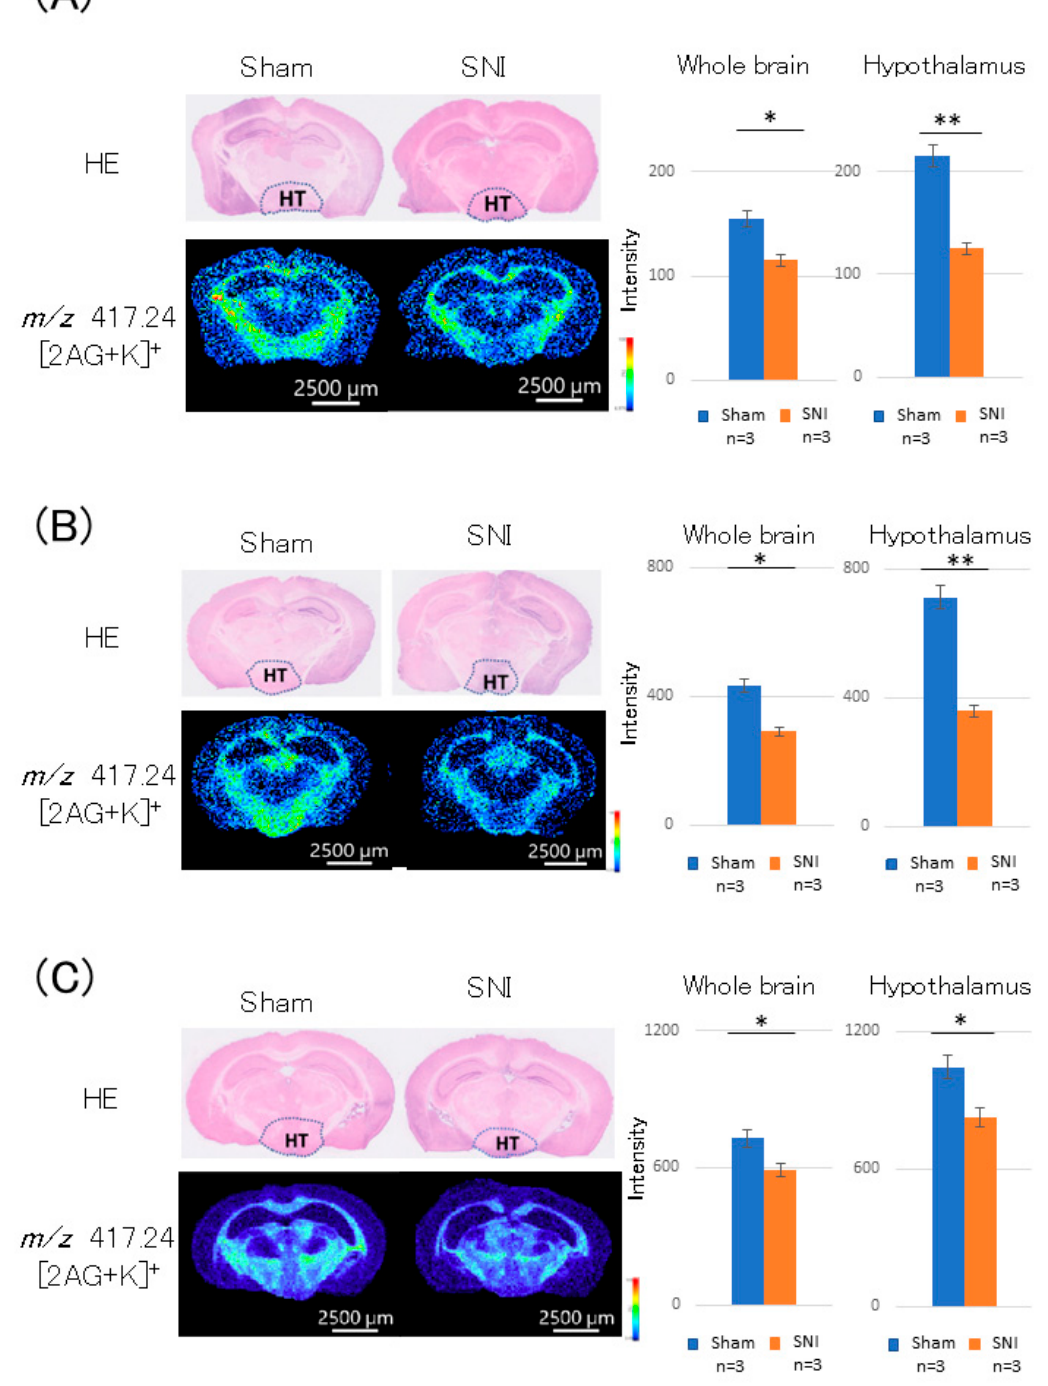
Figure 2. Distribution of 2-AG at the thalamic level in the brain cross-sections of SNI mice. ( A ) On day 3 post-treatment, 2-AG level in the whole brain was reduced in the SNI group. The difference in 2-AG level was particularly pronounced in the hypothalamus, showing a decrease in the SNI group. ( B ) On day 7 post-treatment, 2-AG level in the whole brain was reduced in the SNI group. Furthermore, 2-AG level in the hypothalamus was decreased in the SNI group, similar to the result on day 3 post-treatment. ( C ) On day 21 post-treatment, the SNI group also showed a similar decrease in the 2-AG level, but the difference was smaller. A similar trend was observed in the hypothalamus. *: p < 0.05, **: p < 0.01.